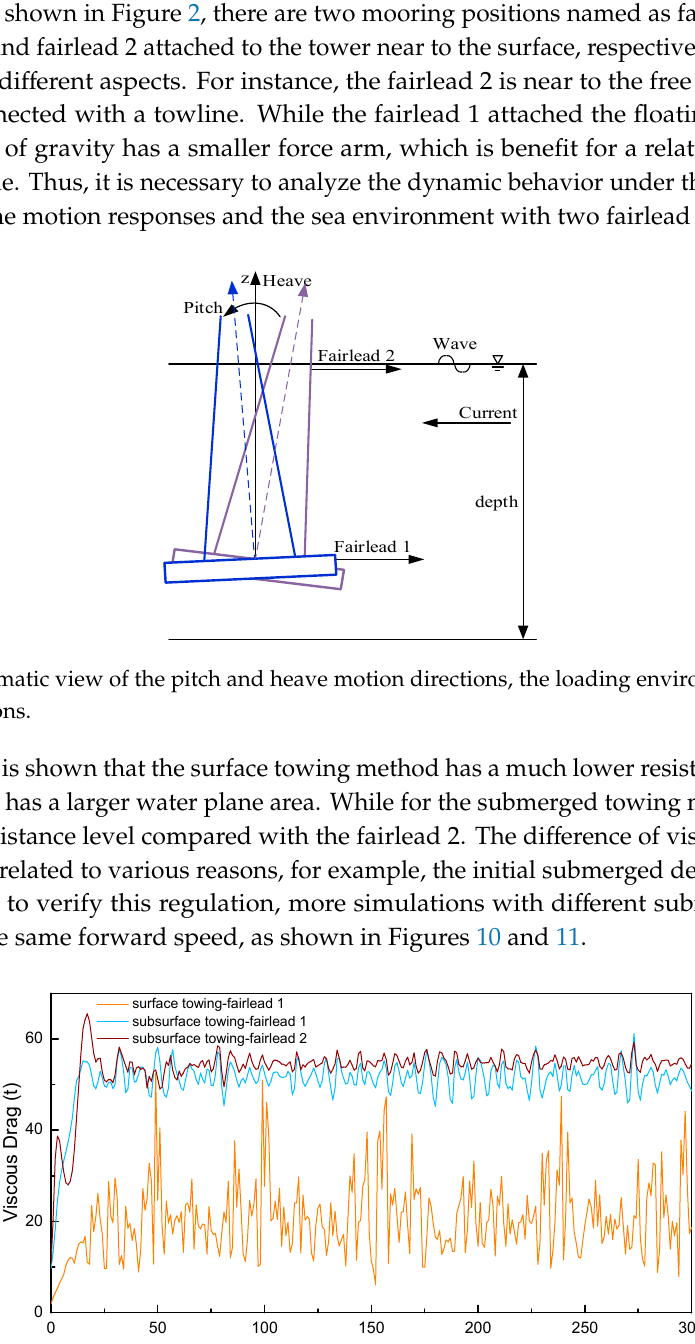
Figure 7. Comparison between the surface towing and the submerged towing under different towing speeds in terms of the viscous drag force and the towing force.